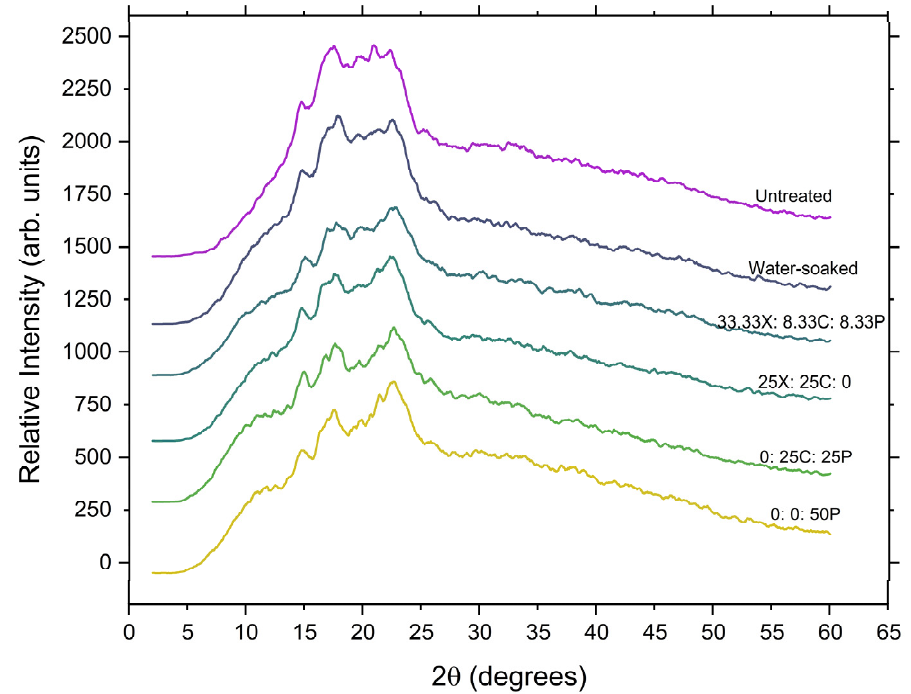
Figure 5. X-ray diffraction patterns of untreated, control (water-soaked), and enzyme-treated grains. X: xylanase; C: cellulase, and P: pectinase.